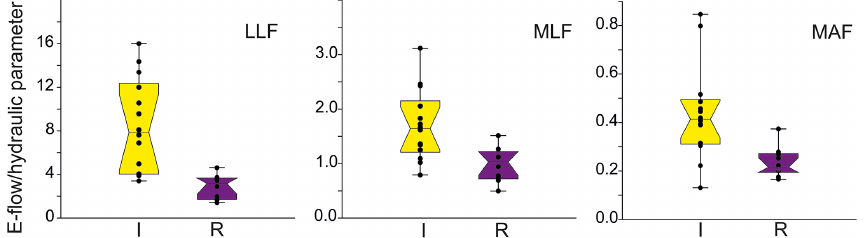
Figure 6. The distribution of mean values ± SE (box) and whisker length (1 σ ) with distribution of jitter of e-flow proportion to low low flow (LLF), mean low flow (MLF), and mean annual flow (MAF) in relation to riverbed modification (I – incision, R –